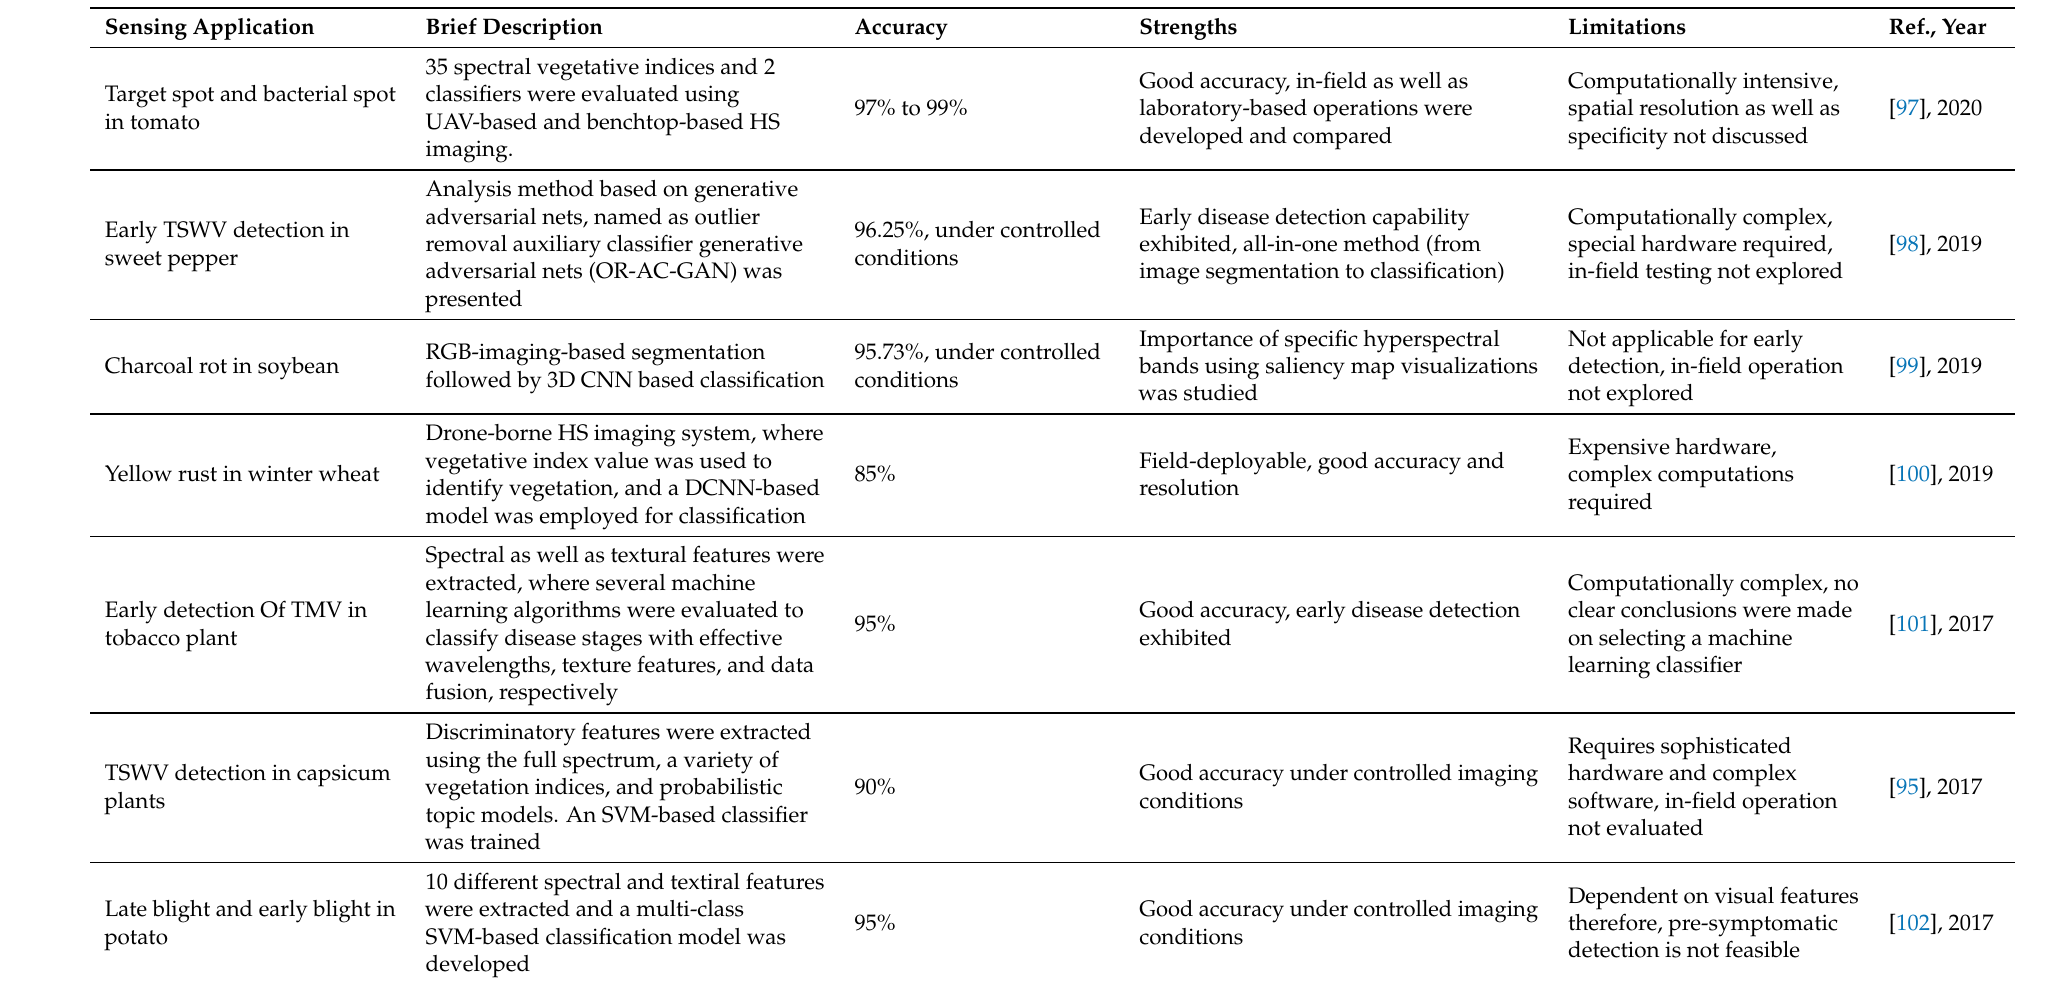
Table 4. A comparison of the key recent hyperspectral (HS) imaging-based sensing methods for monitoring pathogenic stress in